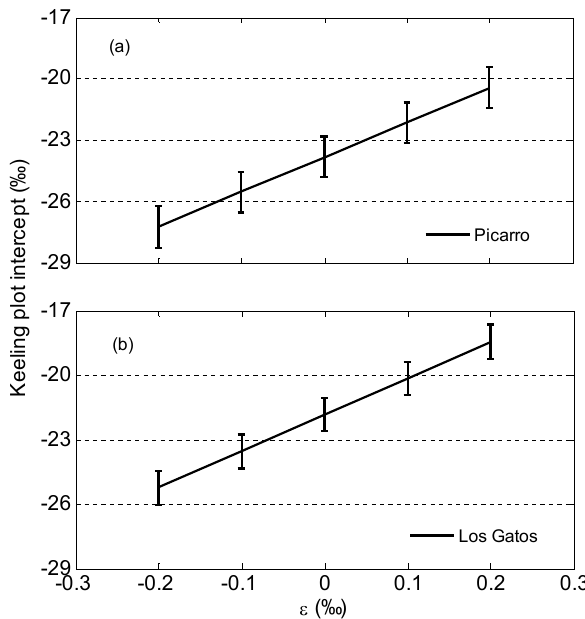
Fig. 7. The relationship of the intercept of the Keeling plot to the parameter specifying the concentration dependence behavior for (a) the Picarro G1101-i and (b) the Los Gatos DLT-100 analyzer. Error bars indicate the 95% confidence